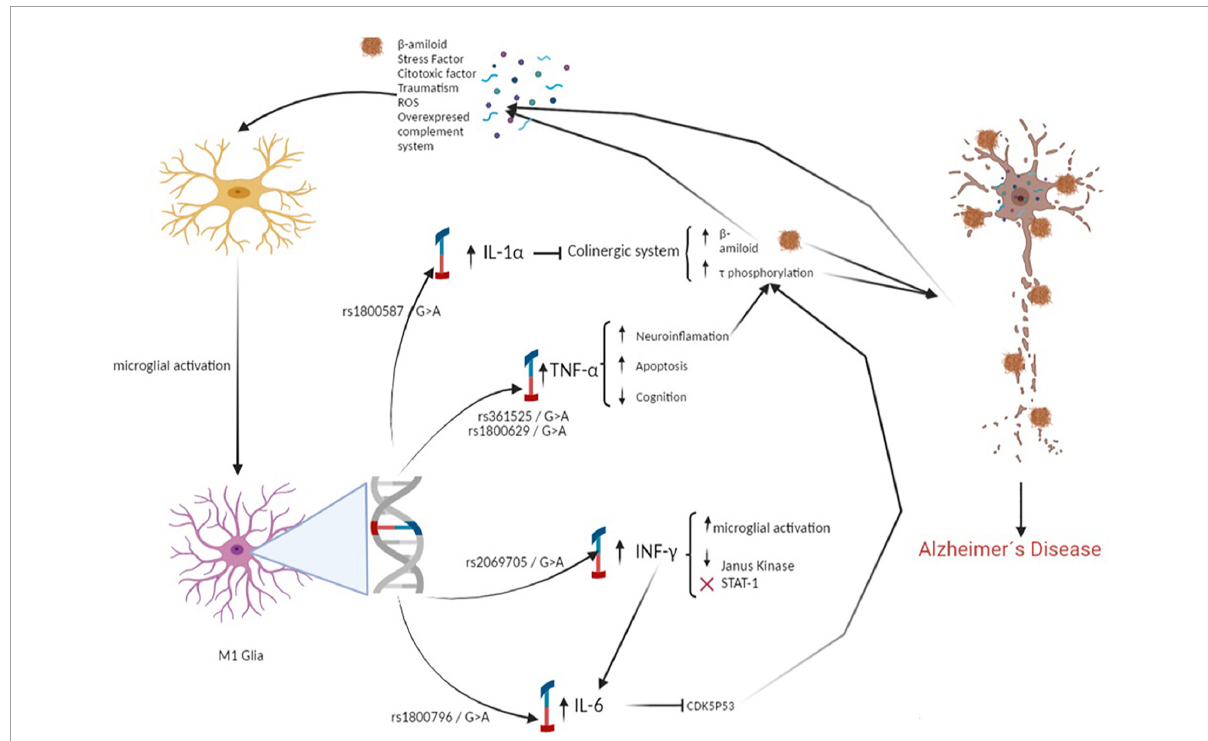
FIGURE3 Polymorphisms associated with the development of dementia increases the proliferation of β -amyloid and promotes Tau hyperphosphorylation. Causing a pathological increase in the inflammatory response, which generates neuroinflammation and neuronal